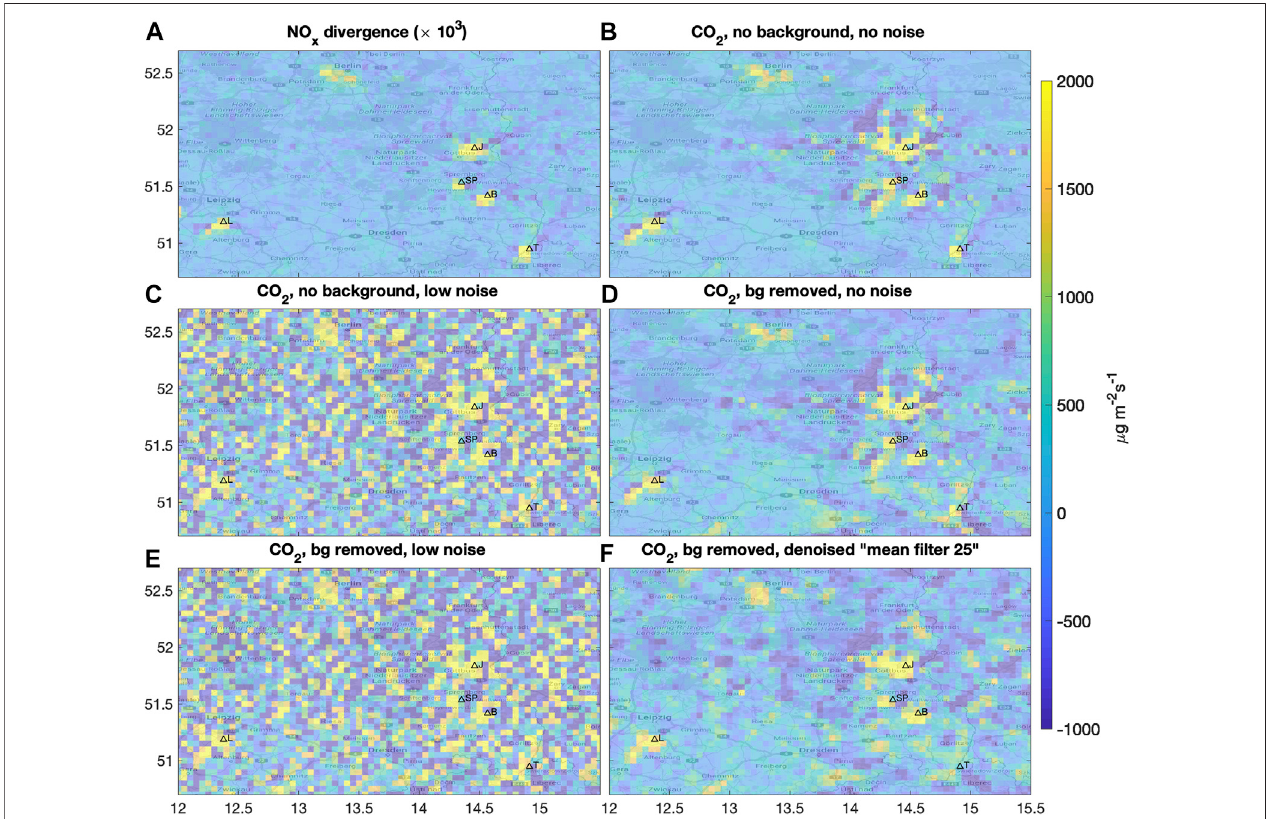
FIGURE 3 | Divergence calculated with various setups. (A) shows the NO x divergence and (B – F) the CO 2 divergence. The different setups are indicated in the title of each panel.